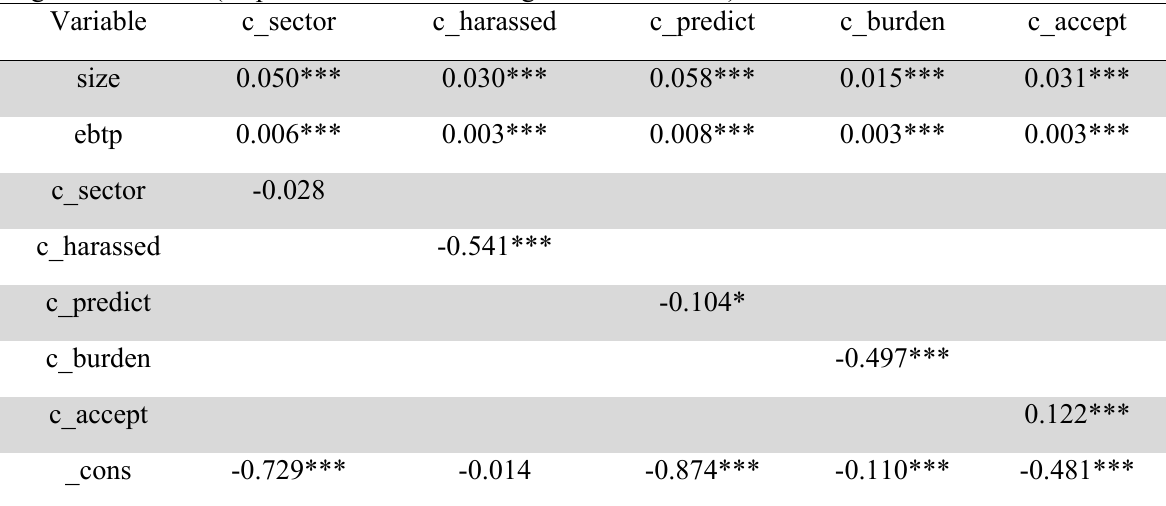
Regression results (Dependent variable:  Long-term